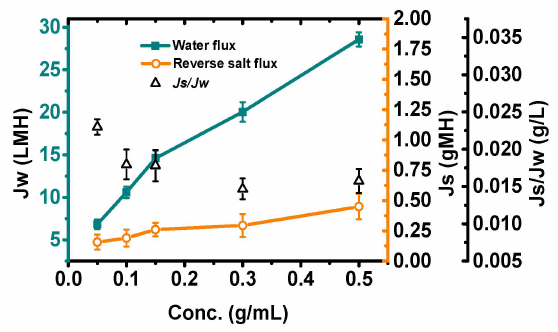
Figure 5. The FO performance with STPH draw solution of different concentrations (pH = 9, PRO mode, DI water as the feed solution).